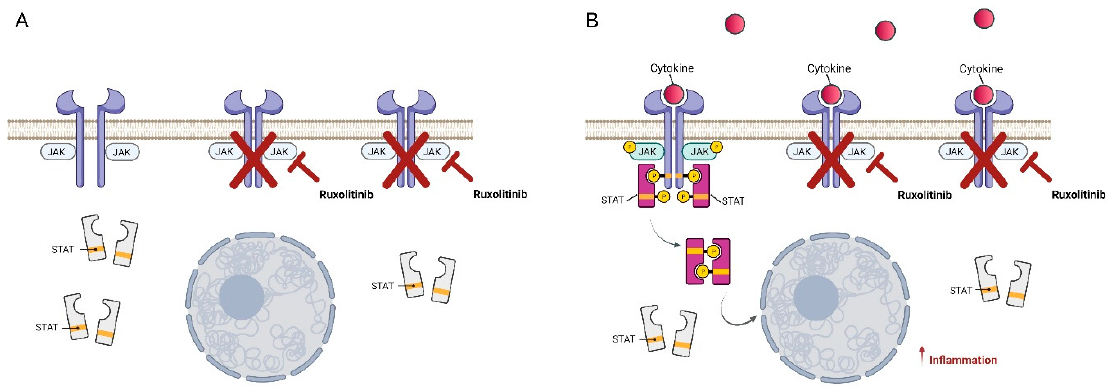
Figure 3. Schematic representation of the preventive anti-inflammatory action of ruxolitinib. ( A ) Ruxolitinib, administered at low dosage and in the absence of cytokine induction, can partially block JAK receptors. ( B ) Partial inhibition of JAK receptors by ruxolitinib reduces STAT activation and prevents hyperinflammation. Created with BioRender.com (accessed on 16 March